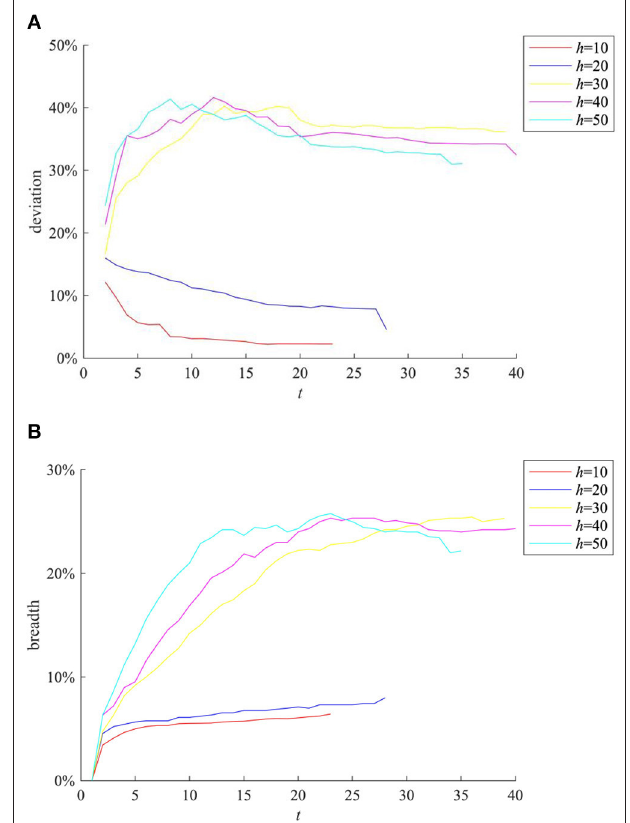
FIGURE 6 | The impact of µ b on rumor evolution process. (A) Entire network information content deviation. (B) Rumor diffusion range. FIGURE 7 | The impact of network structure on rumor evolution process. (A) Entire network information content deviation. (B) Rumor diffusion